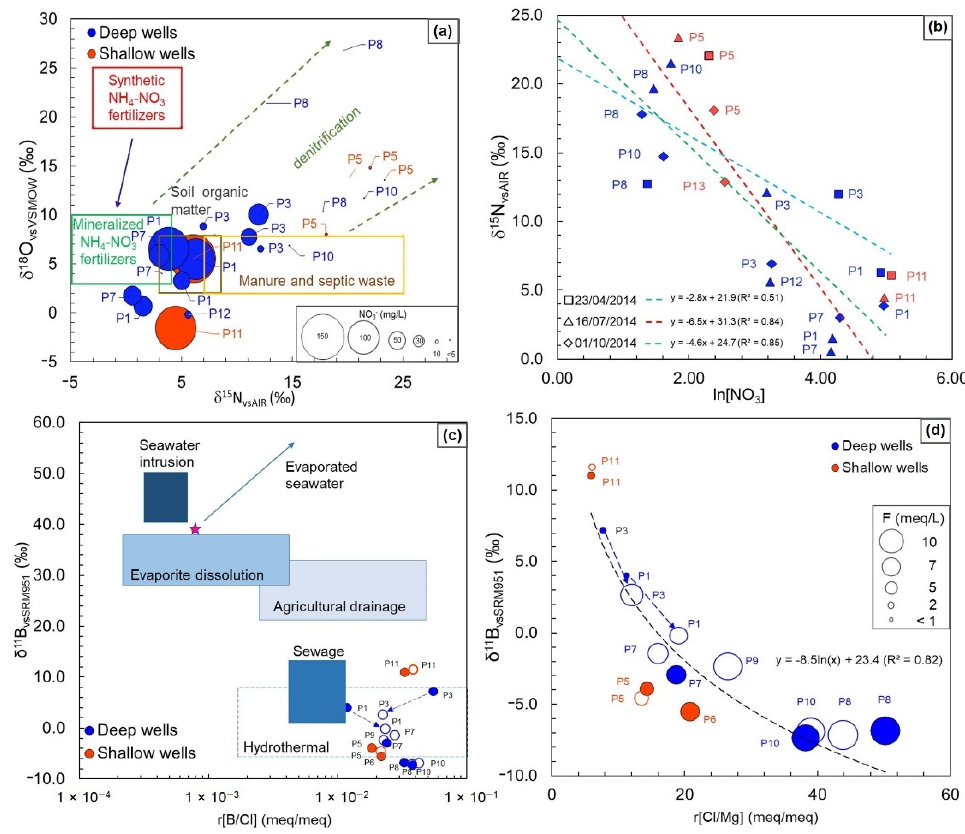
Figure 9. ( a ) δ 18 O vs. δ 15 N of dissolved nitrate in shallow (red bubbles) and deep (blue bubbles) wells. The area of the bubbles is proportional to [NO 3 − ]. The boxes represent the nitrate sources isotopic fingerprint (after [25]). ( b ) Cross-plot of the δ 15 N composition of dissolved NO 3 vs. the natural log of N-NO 3 concentrations (in mg / L) in shallow (red) and deep (blue) wells in the recharge (23 April 2014) and the depletion (16 July 2014, 01 October 2014) periods. ( c ) δ 11 B vs. r[B / Cl] (after [10]) in shallow (red) and deep (blue) wells plot in the recharge (April 2014, closed circles) and the depletion (July 2014, open circles) periods. The boxes represent the typical sources values; the pink star is seawater (SW). ( d ) δ 11 B vs. r[Cl / Mg] in shallow (red) and deep (blue) wells in the recharge (April 2014, closed bubbles) and the depletion (July 2014, open bubbles) periods. The area of the bubbles is proportional to [F −